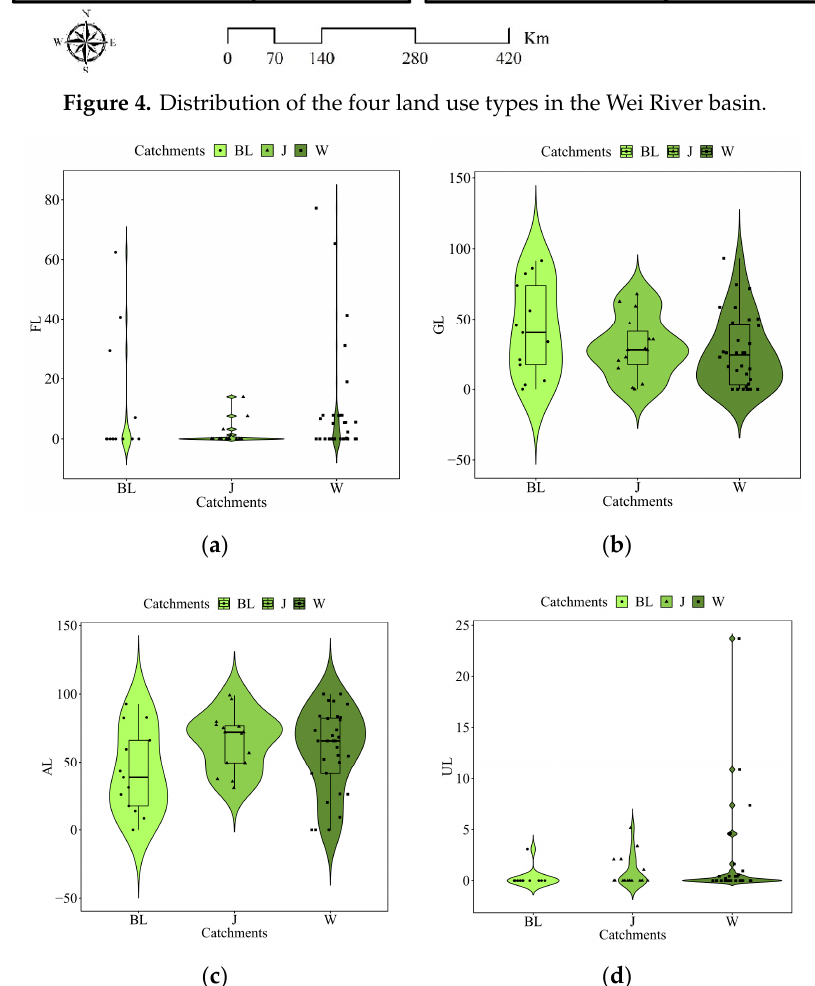
Figure 5. Distribution of the four land use types at three catchments in the Wei River basin. ( a ): forestland (FL), ( b ): grassland (GL), ( c ): agricultural land (AL), ( d ): urban land (UL).